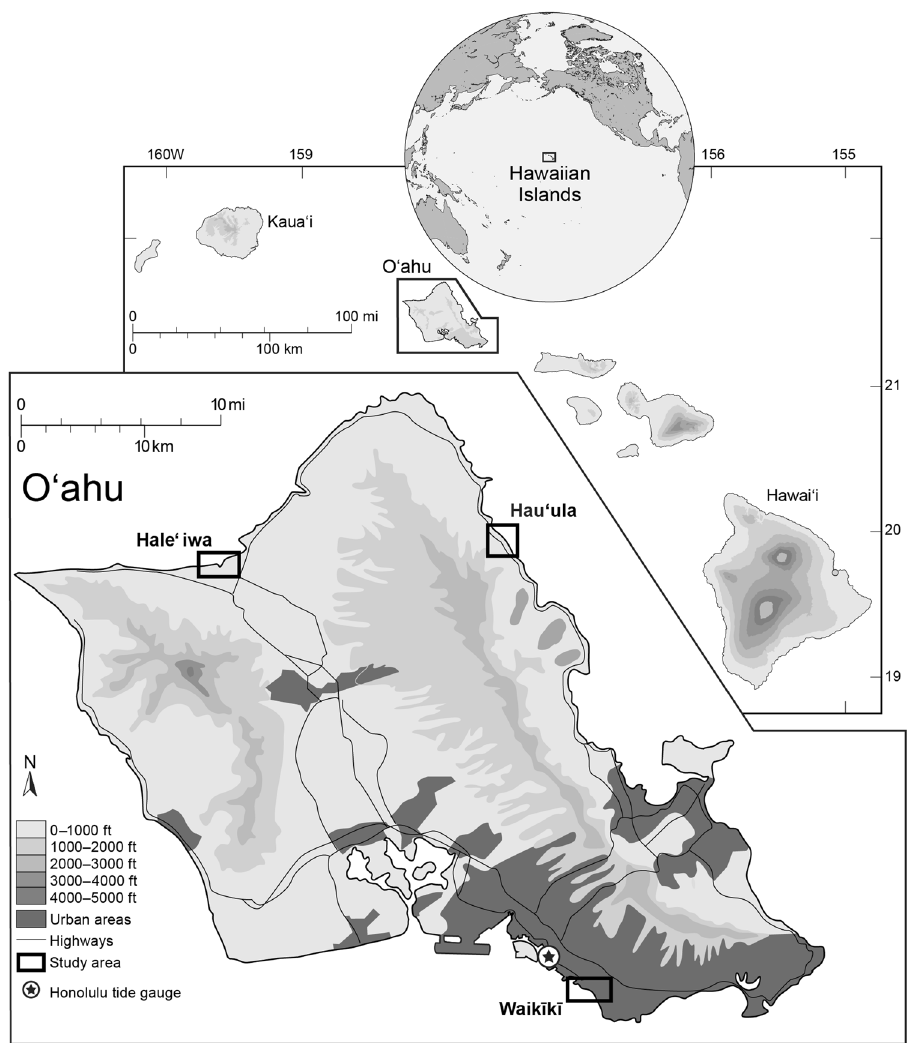
Figure 1. Location of study areas on the island of O ʻ ahu, Hawai ʻ i. Modified from: Fletcher, Mullane and Richmond 40 . Reproduced with permission from the Coastal Education and Research Foundation,